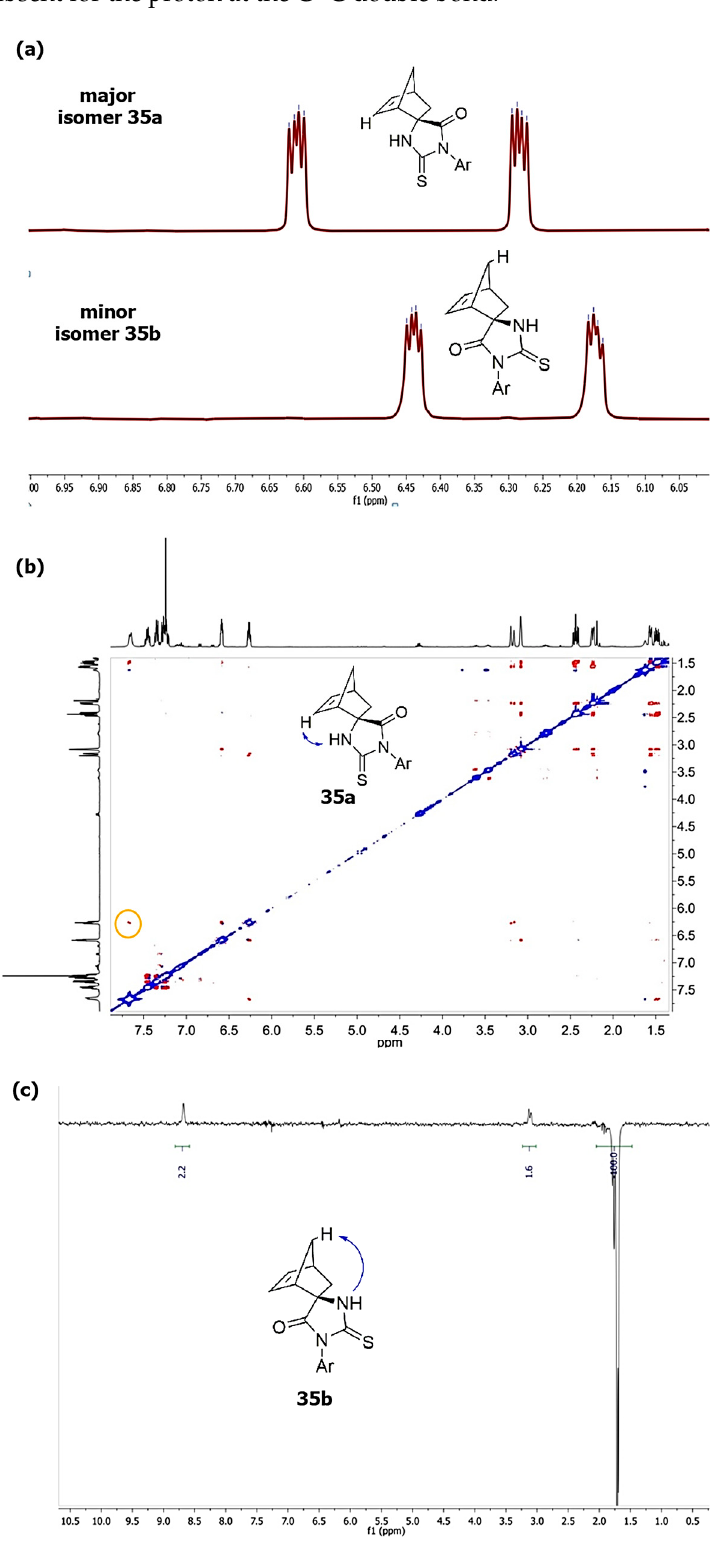
Figure 1. ( a ) Characteristic doublets of doublet set of HC=CH protons of compounds 35a and 35b in their 1 H NMR spectra (CDCl 3 ). ( b ) Characteristic correlations observed in 1 H- 1 H NOESY NMR spectrum of the compounds 35a . ( c ) 1 H NOESY NMR spectrum of compound 35b